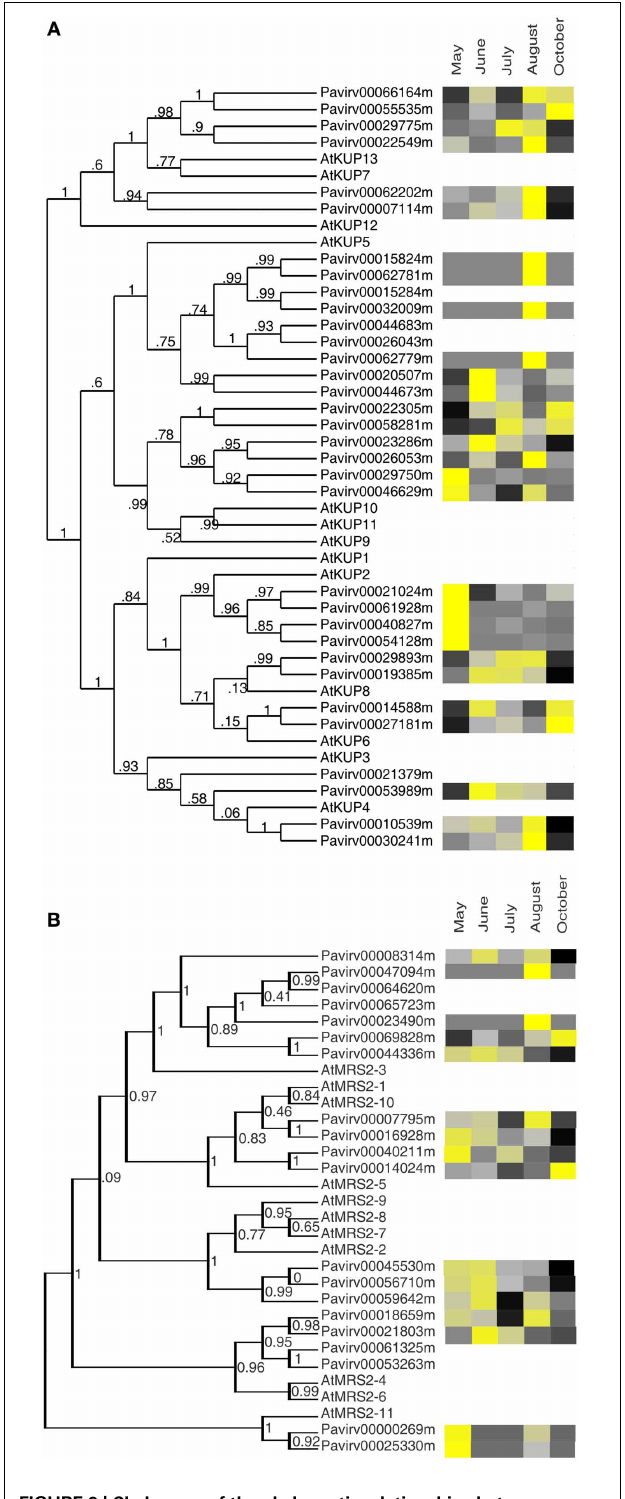
FIGURE 3 | Cladogram of the phylogentic relationships between switchgrass transporter genes to Arabidopsis thaliana orthologs and their expression profiles in crowns and rhizomes of field grown cv Summer plants. (A) Potassium transporters (KUP) (B) Magnesium transporters (MRS). Other details are as described for Figure 2